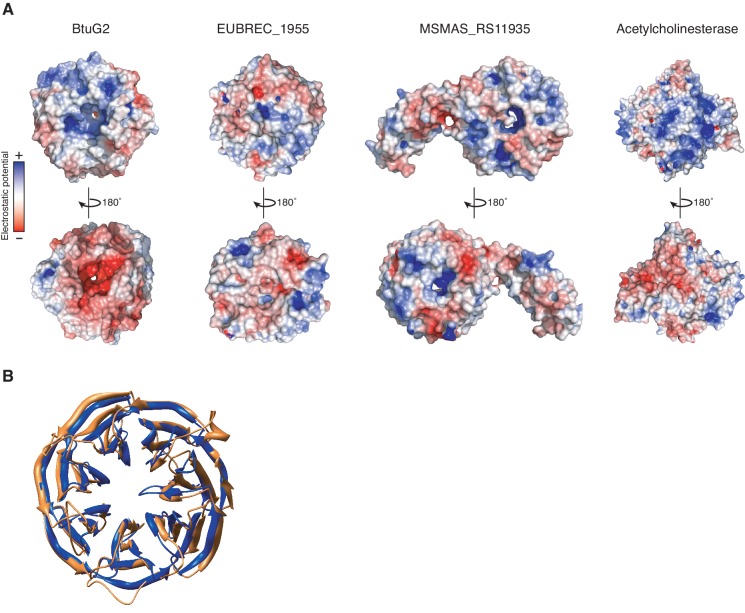
Surface electrostatic profiles of the seven-bladed β-propeller proteins BtuG2, EUBREC_1955 and MSMAS_RS11935, and the globular enzyme acetylcholinesterase.(A) Model of surface electrostatic profile based on the crystal structure of BtuG2 (PDB 3DSM; left) reveals a largely positive electrostatic potential (blue) on the face of BtuG2 harboring the C-terminal 6xHis tag, and a largely negative electrostatic potential (red) on the opposing face, unlike the unrelated seven-bladed β-propellers EUBREC_1955 from the human gut anaerobe Eubacterium rectale (PDB 3S25; center left) and MSMAS_RS11935 from the methanogenic archeon Methanosarcina mazei (PDB 1L0Q; center right). Opposing electrostatic charge surfaces on enzymes like acetylcholinesterase (PDB 1GQR; right) are thought to aid in ligand orientation and binding during catalysis (Tan et al., 1993; Getzoff et al., 1983; Ripoll et al., 1993). (B) Structural similarity between BtuG2 (PDB 3DSM; gold) and the β-propeller domain of MSMAS_RS11935 (PDB 1L0Q; blue) (Jing et al., 2002). These domains are superimposed with a root mean square deviation of 1.75 Å.